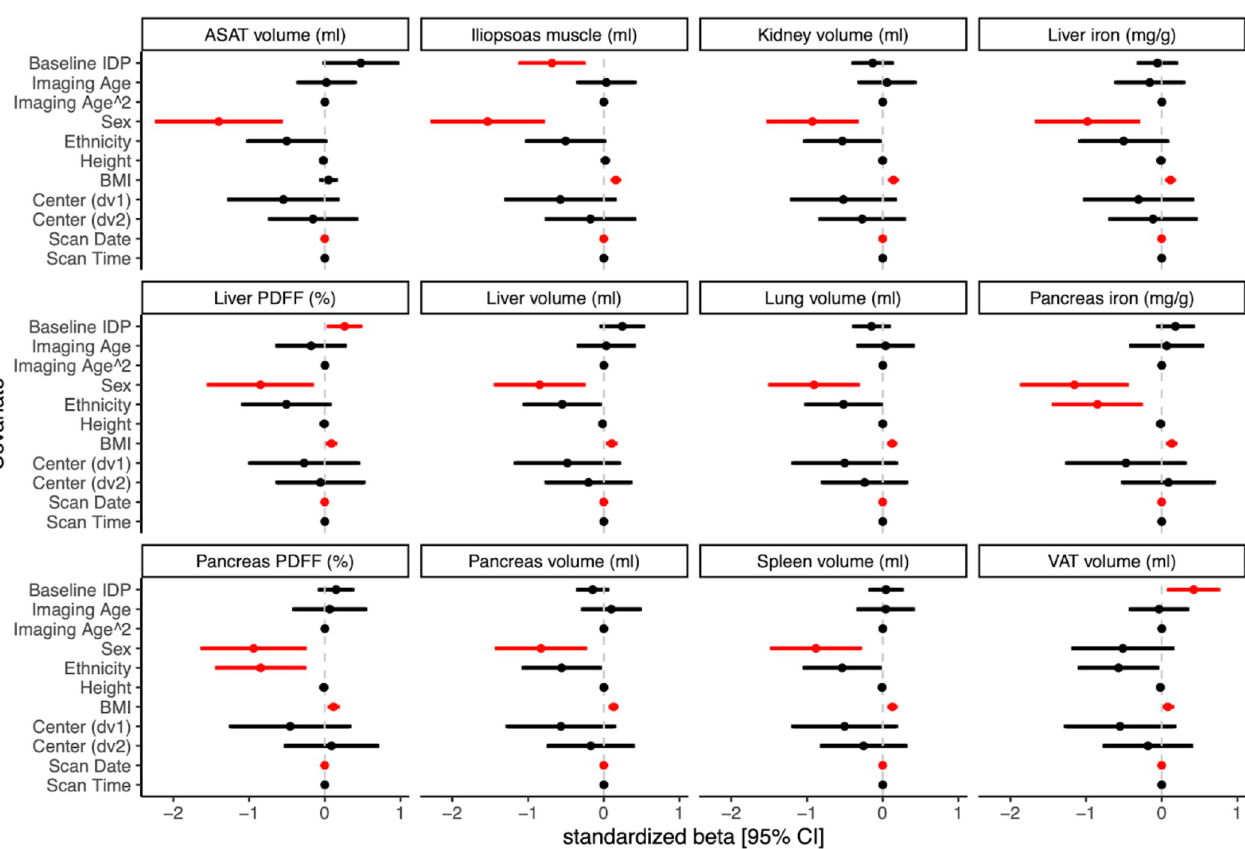
Fig 3. COVID-19 severity and associations with baseline image-derived phenotypes. For this regression model, severity was defined by both death (n = 30) and hospitalization (n = 149), for a total of n = 179 cases compared to n = 928 non-hospitalized COVID-19 positive controls. 95% confidence intervals around standardized betas are shown. Significant associations (FDR < 0.05) are depicted in red. Some binomial variables have large confidence intervals due to class imbalance.